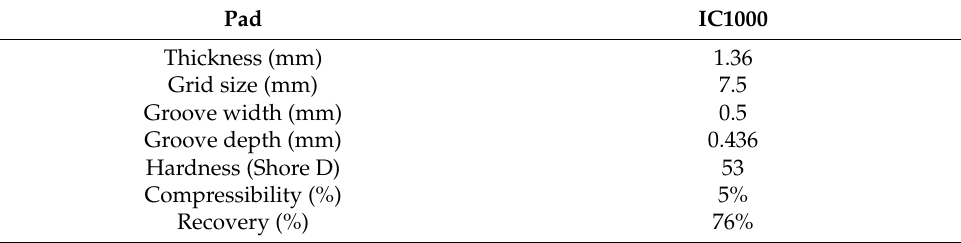
Table 1. Characteristics of IC1000